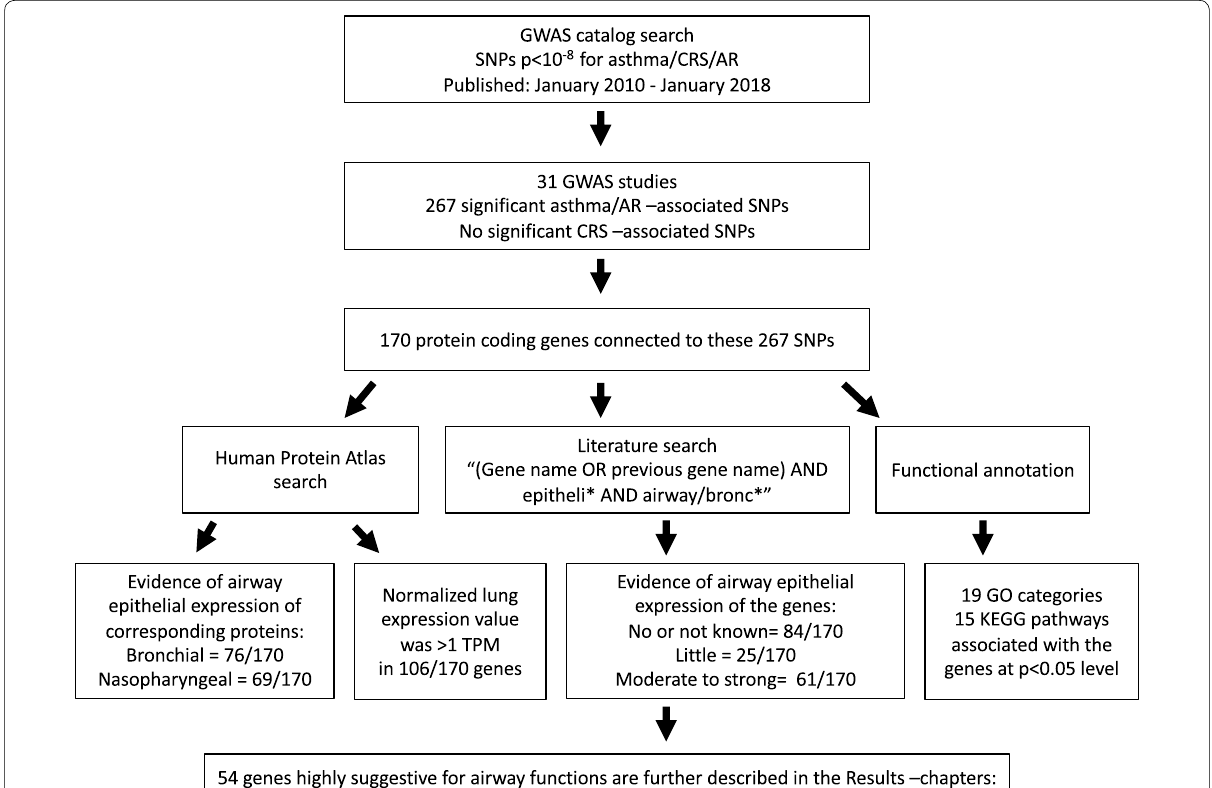
Fig. 1 Flow chart of the study. GWASs were searched from databases (https ://www.ebi.ac.uk/gwas/) and a list and database of SNPs associating significantly (p < 10 –8 ) with asthma, AR and CRS was formed in 1/2018. Gene Ontology (GO) and Kyoto Encyclopedia of Genes and Genomes (KEGG) annotation analysis was performed for protein coding genes connected to SNPs. Airway epithelial expression of genes and corresponding proteins were evaluated by using Gene Cards, Human Protein Atlas (HPA), and literature search from PubMed. Other potential airway functions of the selected set of genes were evaluated from database /literature search. Abbreviations: AR allergic rhinitis, CRS chronic rhinosinusitis, GO Gene Ontology, GWAS genome‑wide association study, HPA Human Protein Atlas, KEGG Kyoto Encyclopedia of Genes and Genomes, SNP single nucleotide polymorphism, TPM Transcripts Per Million